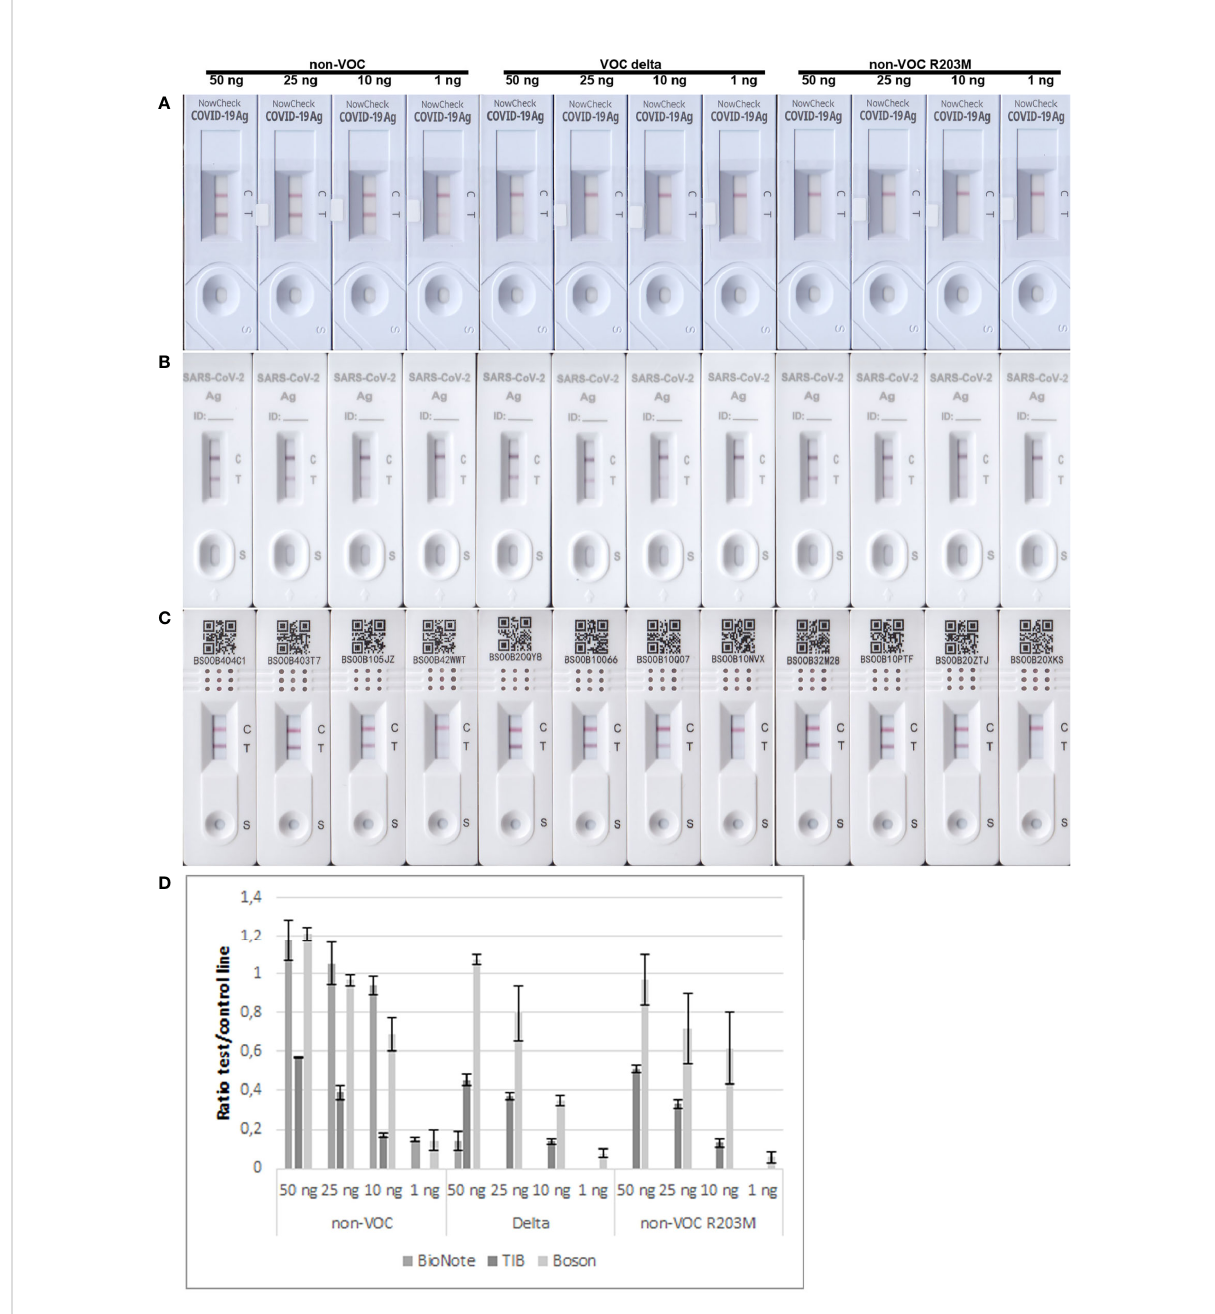
FIGURE 6 Limits of detection of BioNote, TIB, and Boson RATs for detection of non-VOC, Delta, and non-VOC R203M recombinant proteins. (A) BioNote, (B) TIB, (C) Boson, using amounts of 50 ng, 25 ng, 10 ng, 1 ng respectively. (D) Means of densitometric analysis of RATs is shown in (A – C)